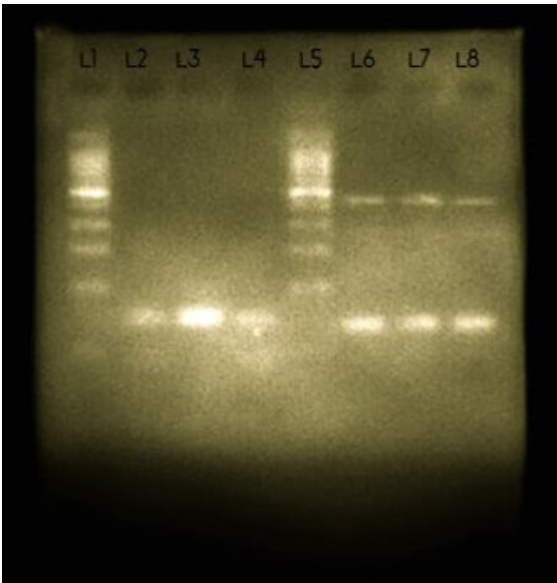
Figure 3: The 1.5% Agarose gel image stained with Ethidium bromide for the diagnostic fragments of morphospecies A and morphospecies B (Lane 1(L1) and L5 – 100bp ladder, L2-L4 PCR products for morphospecies A; L6-L8 PCR products for morphospecies B).